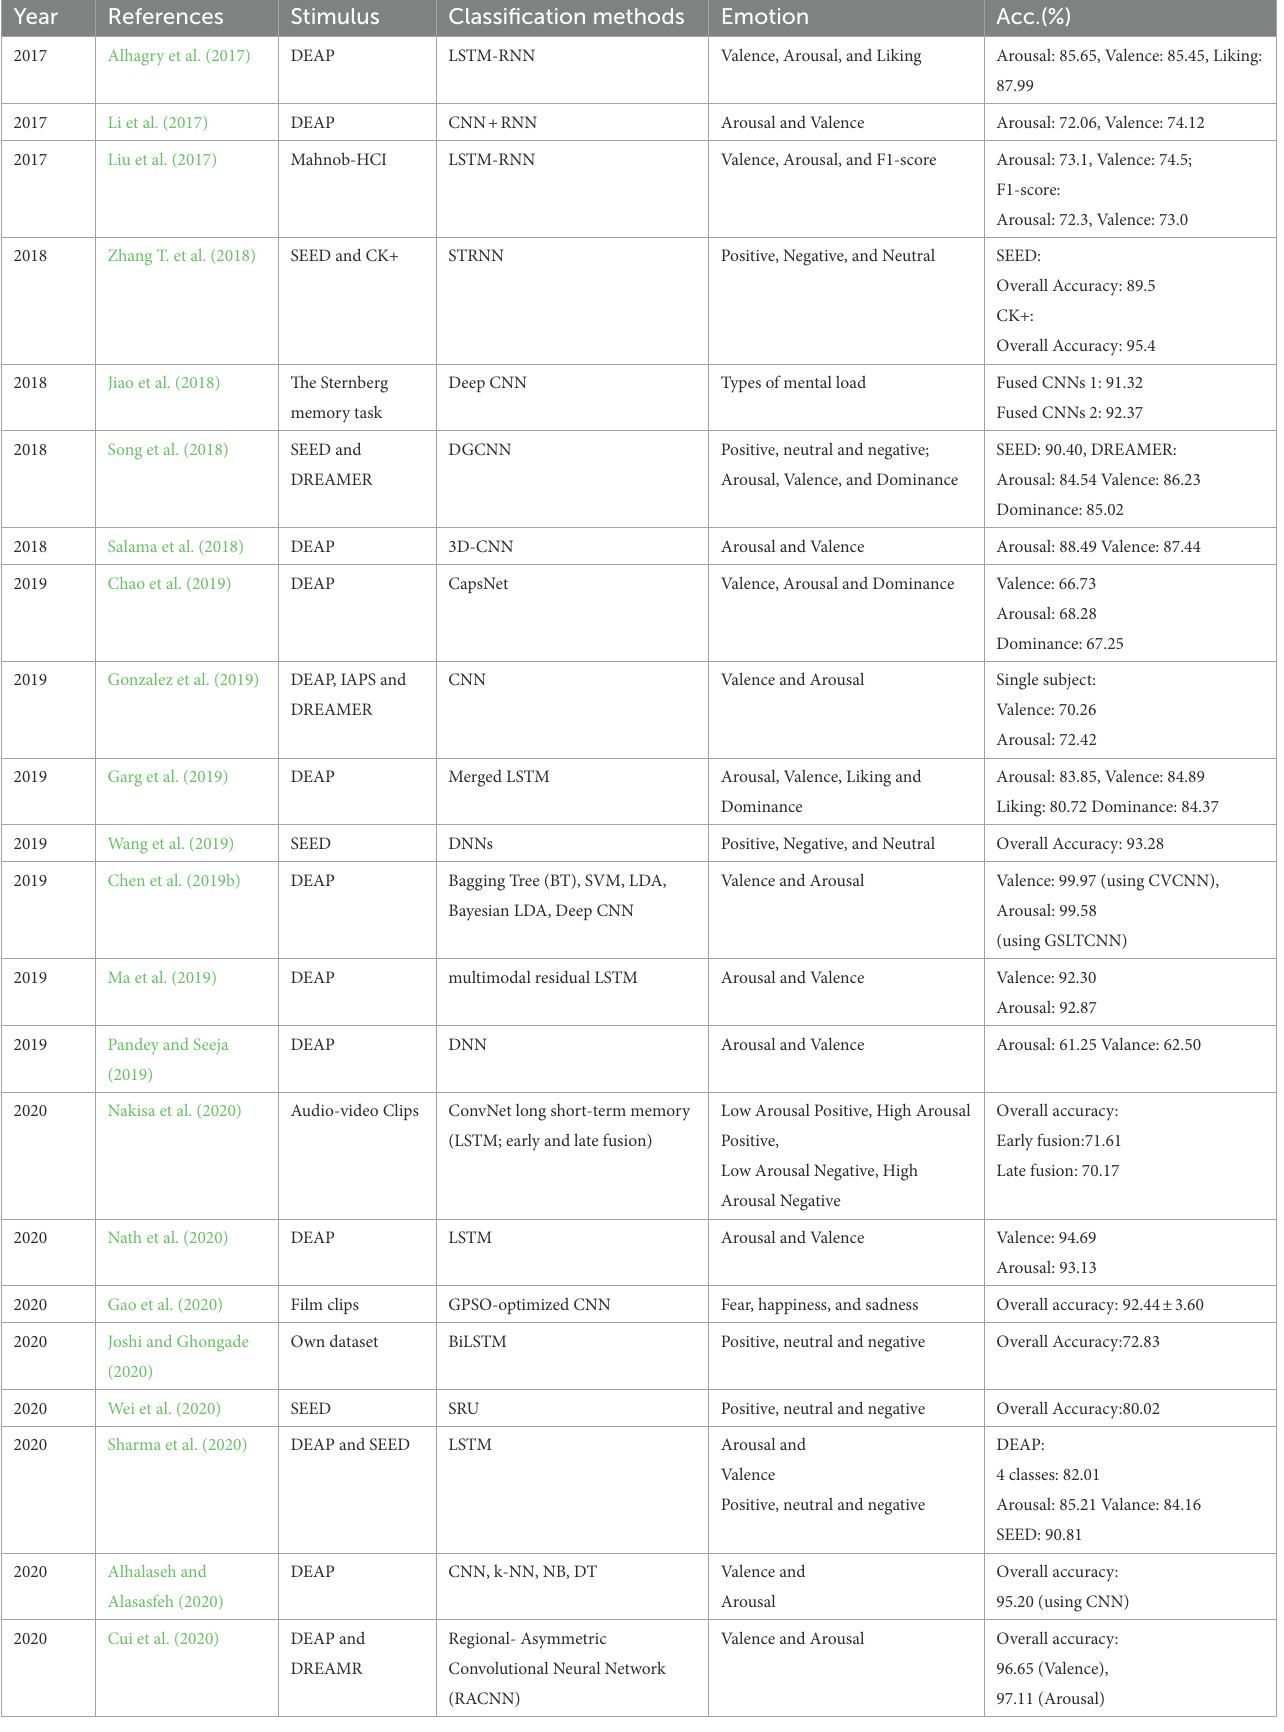
TABLE 2 Summary of EEG emotion recognition papers using Deep learning methods from 2017 to